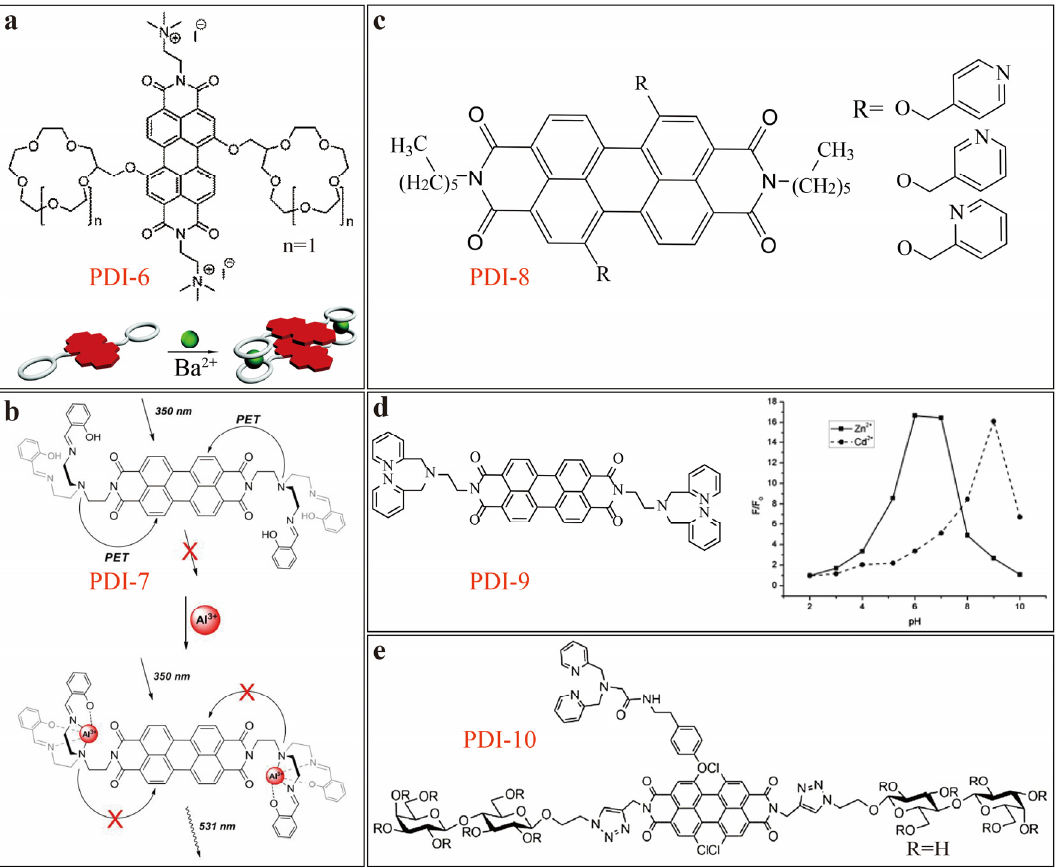
Figure 4. ( a ) Molecular structures of crown ether functionalized PDIs and the dimer formed via complexation between crown ether and Ba 2+ ion. Reproduced with permission from [12], copyright 2015 Royal Society of Chemistry. ( b ) Fluorescence turn-on sensing mechanism of PDI-7 towards Al 3+ . Reproduced with permission from [13], copyright 2014 Elsevier. ( c ) Molecular structures of three PDIs modified with three pyridine isomers. ( d ) Molecular structure of PDI-9, and the effect of pH on their fluorescence response to Zn 2+ and Cd 2+ in ACN/HEPES buffer (1/1, v/v) solutions. Reproduced with permission from [15], copyright 2013 Royal Society of Chemistry. ( e ) Molecular structure of PDI-10.